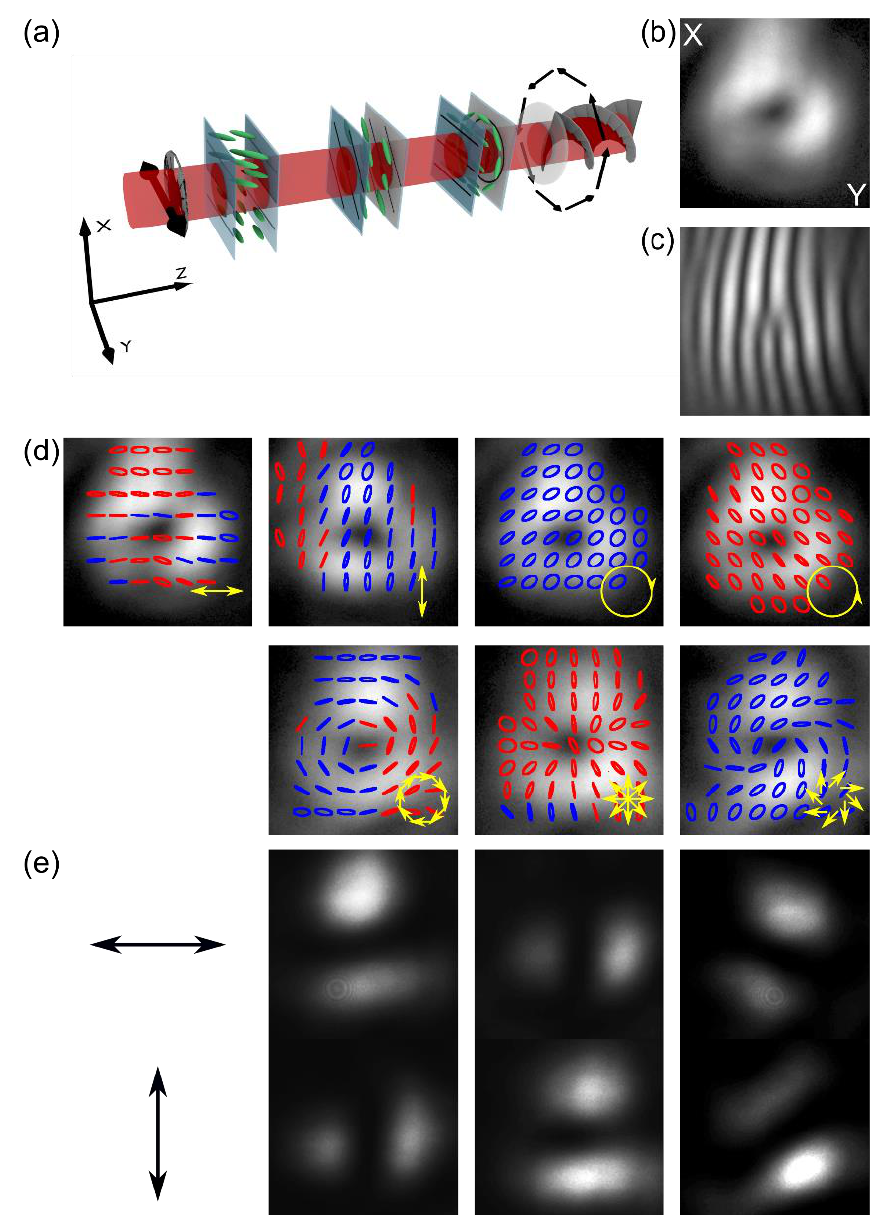
Figure 4. ( a ) Schematic representation of Gaussian-vortex polarization converter consisting of NLC- PC and VM; The result of linearly polarized Gaussian beam transformation into an optical vortex: ( b ) doughnut-shaped intensity profile of a linear (horizontal) output polarization, ( c ) fork-like inter- ference fringes; ( d ) the result of the polarization conversion of the vortex beam into seven different SOPs (from the left-top panel): linear horizontal, linear vertical, circular right- and left-handed, azimuthal, radial, and vortical; ( e ) horizontal (top panels) and vertical (bottom panels) linear polar- ization components (schematically marked by the black arrows) of azimuthal, radial, and vortical SOPs.